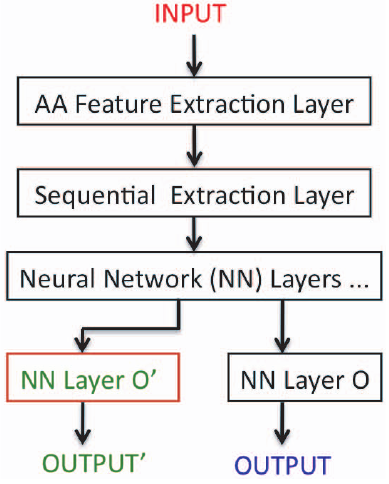
Figure 2. Multitask learning with weight sharing between multiple deep neural networks. In this figure, two related tasks are trained simultaneously using the network the architecture from Figure 1. Here only the very last layers of the network are task specific.